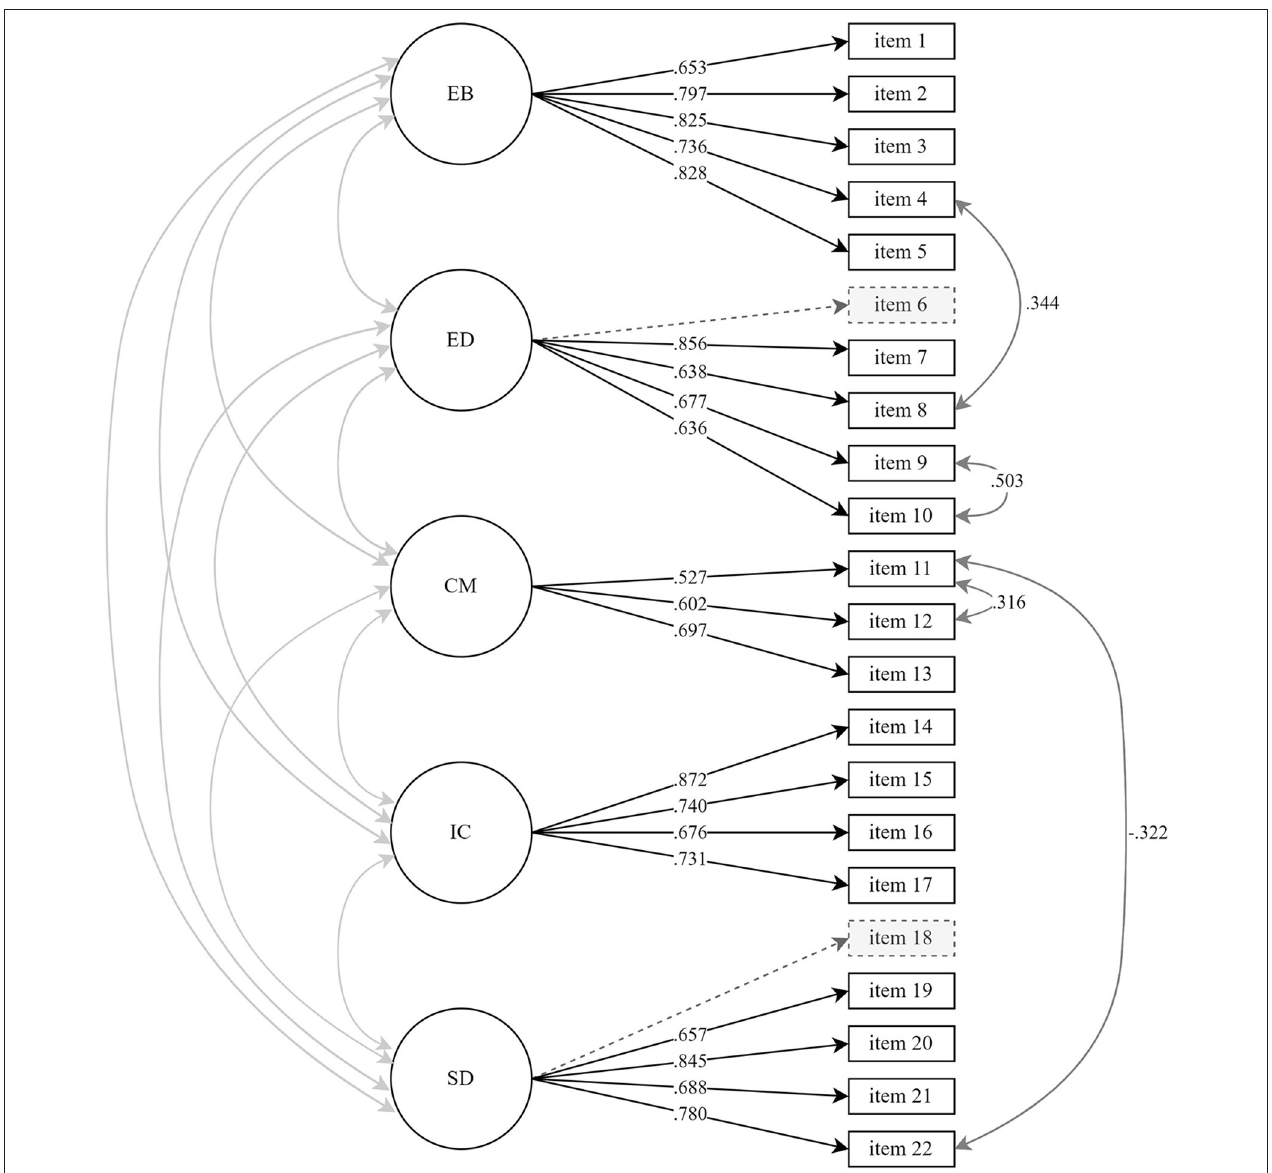
FIGURE 1 | Final 5-factor model pre-transition questionnaire (W1) with standardized estimates. Changes from the conceptual model are marked with dotted markings, indicating the removal of items 6 and 18, and with dark grey arrows, indicating correlation between error terms. EB, exploration in-breadth; ED, exploration in-depth; CM, commitment making; IC, identification with commitments; SD, self-doubt. n =